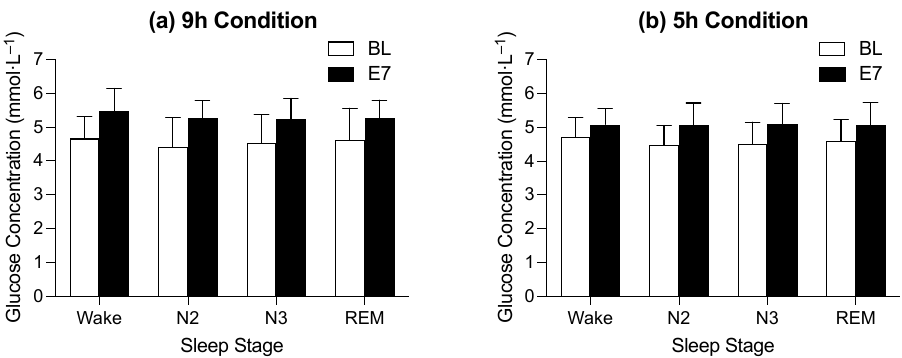
Figure 3. Figure indicates the difference between average glucose concentration on baseline (BL, white bars) and experimental night seven (E7, black bars) in the 9 h time-in-bed condition ( a ) and the 5 h time-in-bed condition ( b ) in the different sleep stages. The y -axis indicates glucose concentration in mmol·L − 1 , and the x -axis indicates sleep stages where Wake = wake after sleep onset, N2 = stage N2, N3 = stage N3, and R = REM sleep.